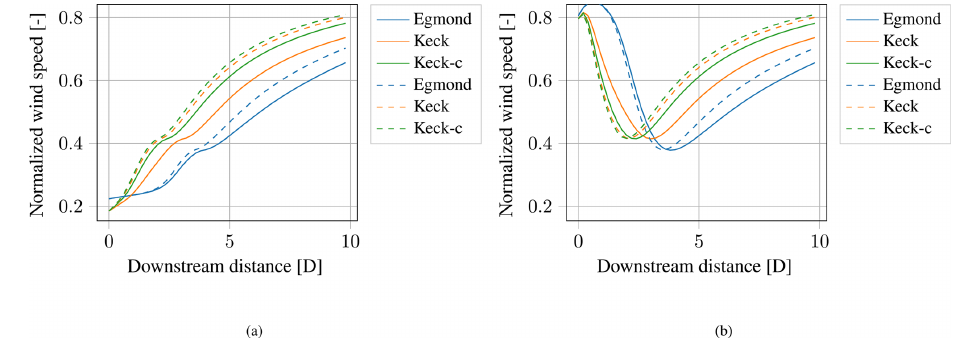
Figure 15. Simulated minimal normalized wind speed in the MFR (a) and normalized wind speed at the wake center (b) over the downstream distance for a turbulence intensity of 6% (solid curves) and 16% (dashed curves). The recalibrated model is denoted